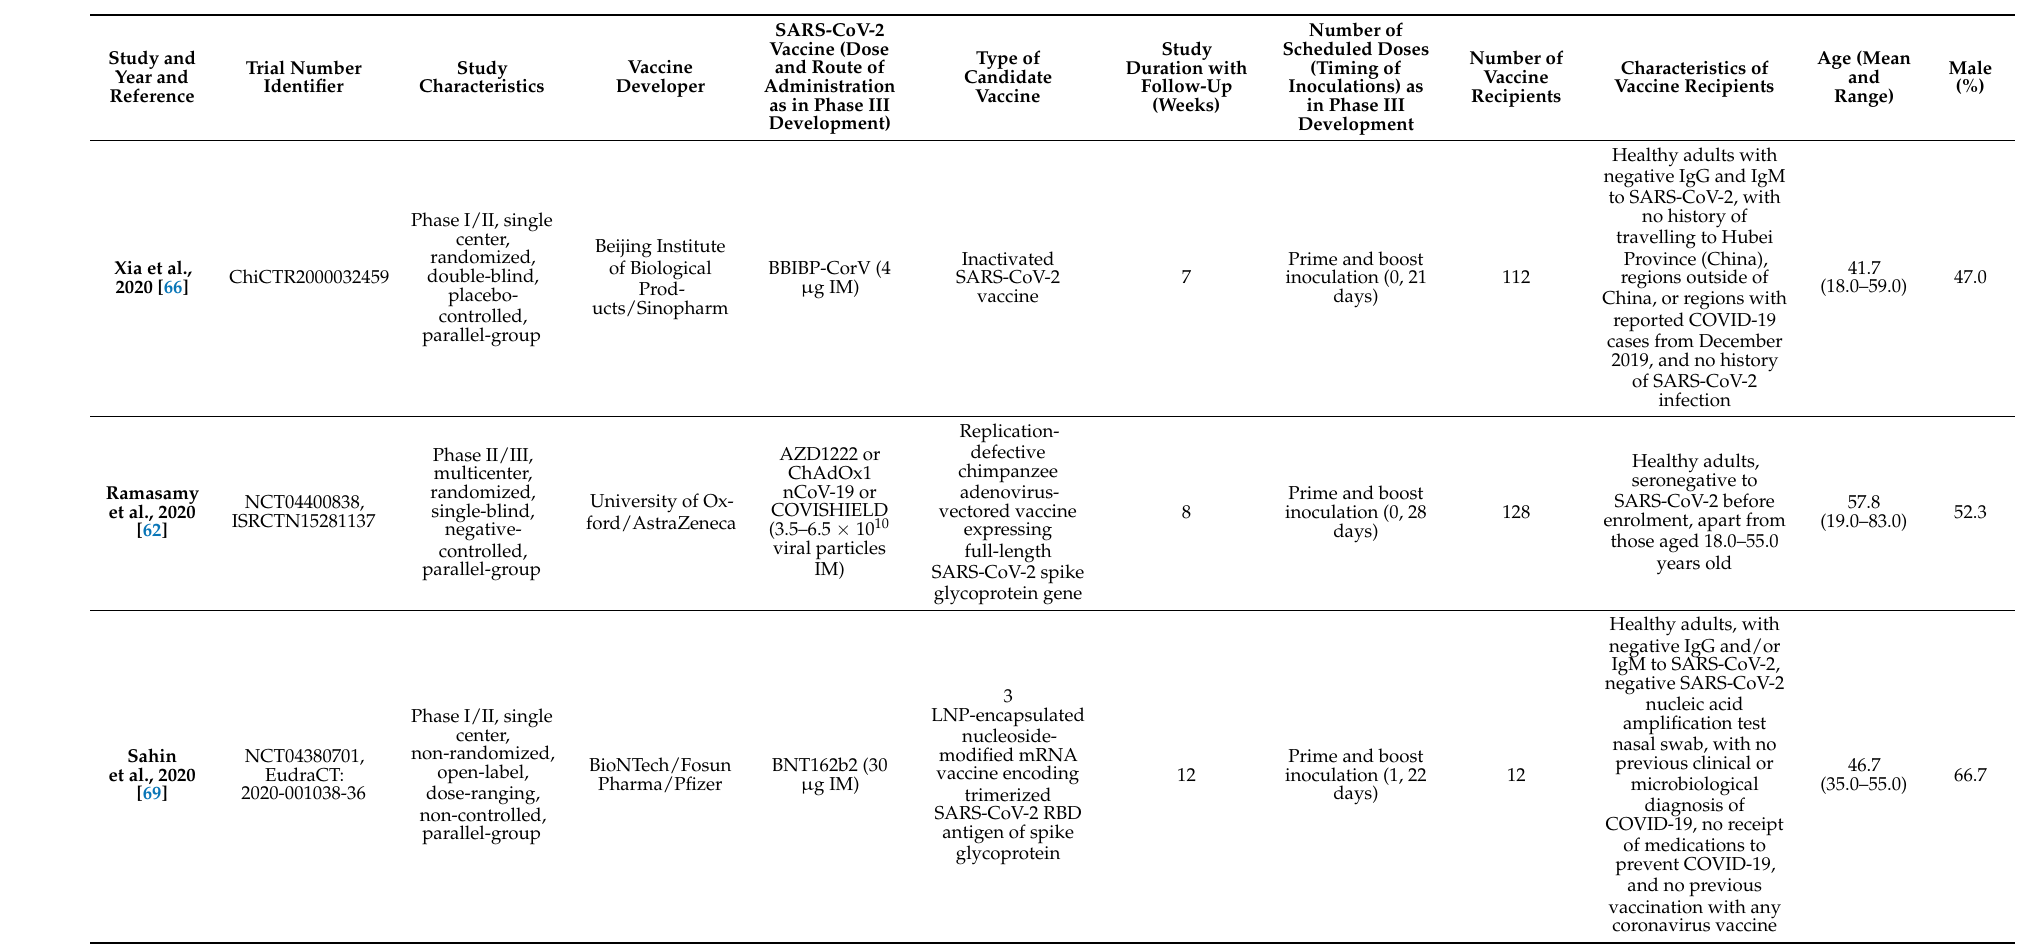
Table 1. Characteristics of the clinical studies included in the network